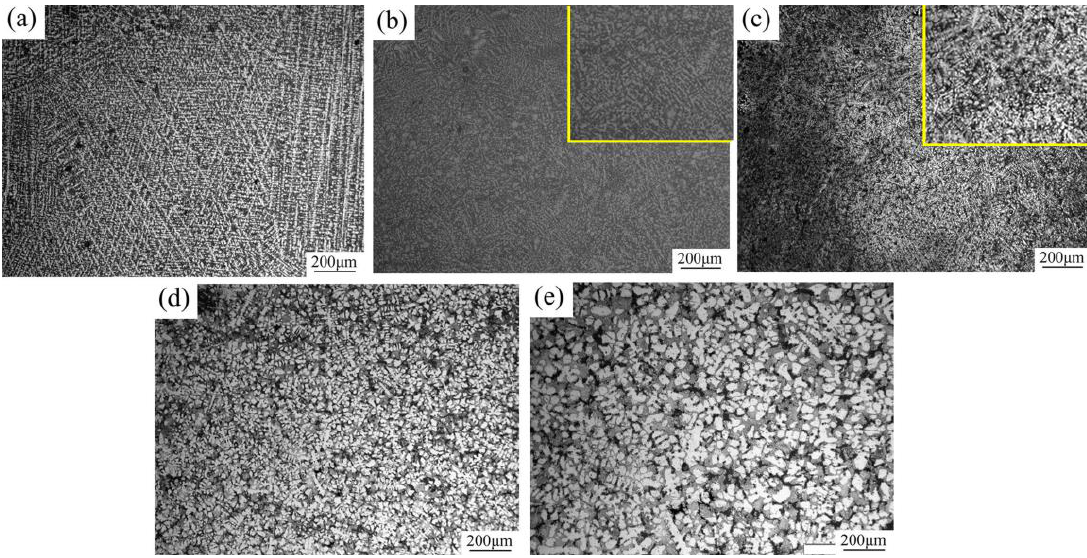
Figure 3. Effect of various isothermal treatment temperatures on the quenching microstructure of Ni-Cr-W superalloy: ( a ) 1480 °C; ( b ) 1420 °C; ( c ) 1410 °C; ( d ) 1400 °C; ( e ) 1390 °C.